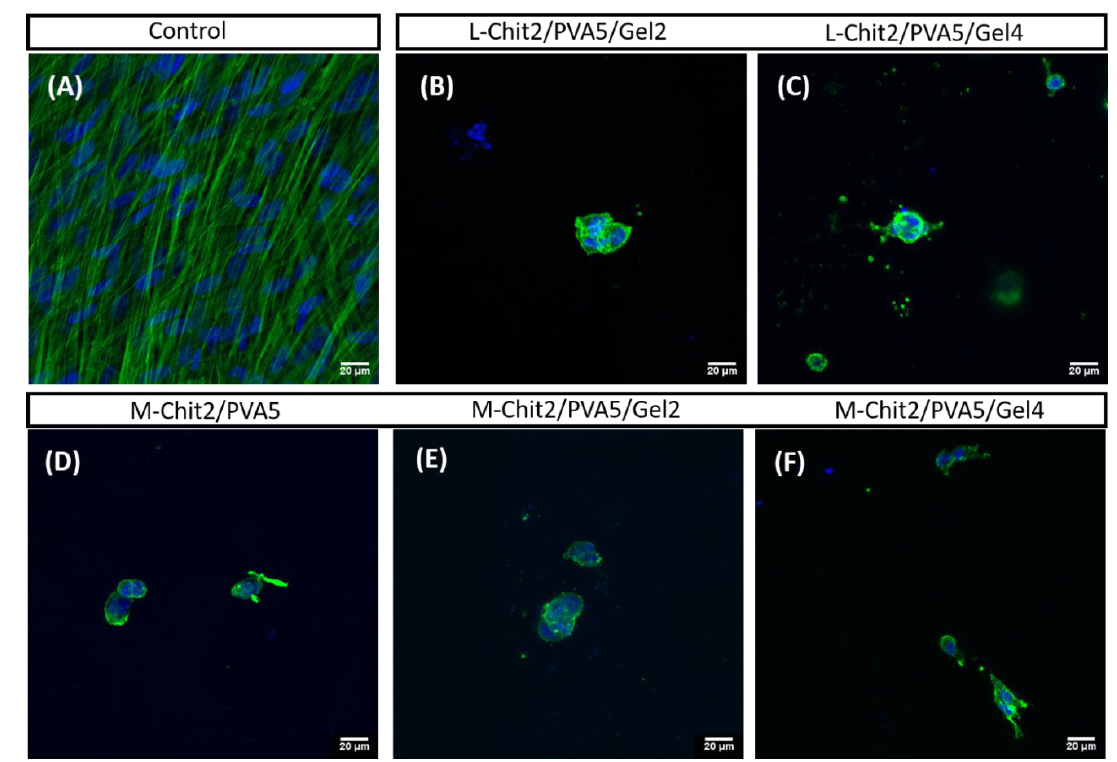
Figure 7. HFFF2 cells growing in culture for 7 days: ( A ) control cells; ( B – F ) 10 kGy irradiated Chit/PVA-based membranes (green: actin; blue: DNA). Scale bars: 20 µm.